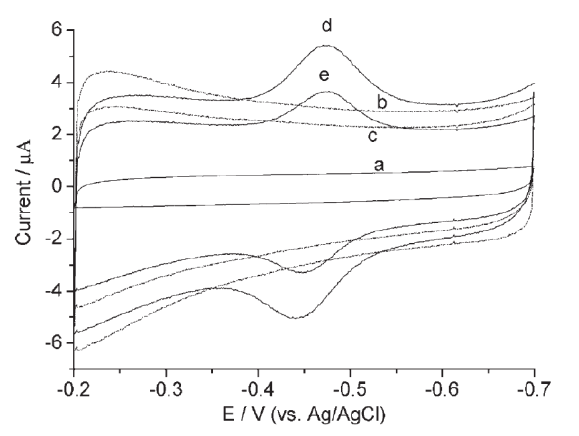
Figure 6. Cyclic voltammograms of a) GCE, b) Pretreated GCE, c) ZrO CYP2B6/ZrO /Pt-PLL/GCE, and e) CYP2B6/GCE in 0.1 M pH 7.4 PBS at 100 mV/s. 2 Reprinted from reference [44] with permission from